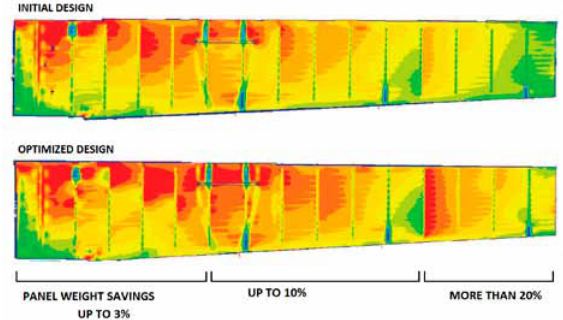
Fig. 8. A comparison of the stress distribution in the initial and optimized designs